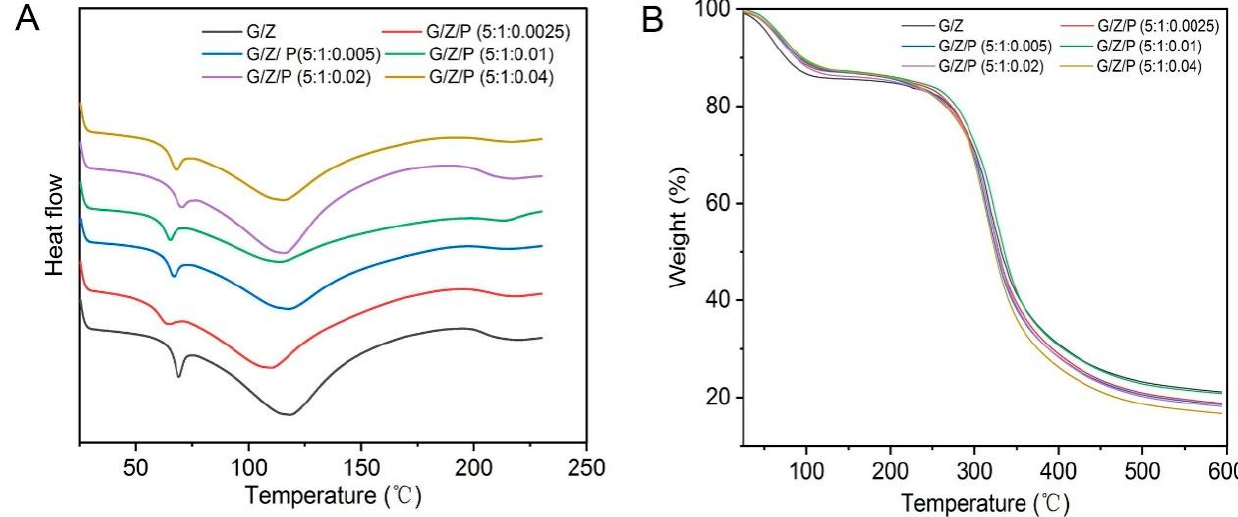
Figure 6. DSC curves ( A ) and TGA thermogram curves ( B ) of the gelatin/zein/perillaldehyde nanofibers.